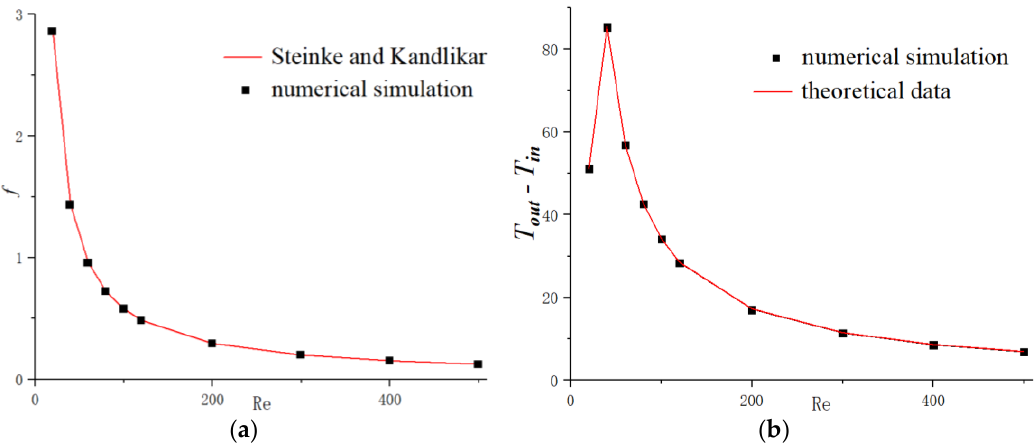
Figure 3. Comparison of numerical results with theoretical data for smooth microchannel heat sink. ( a ) f ; ( b ) T out − T in .